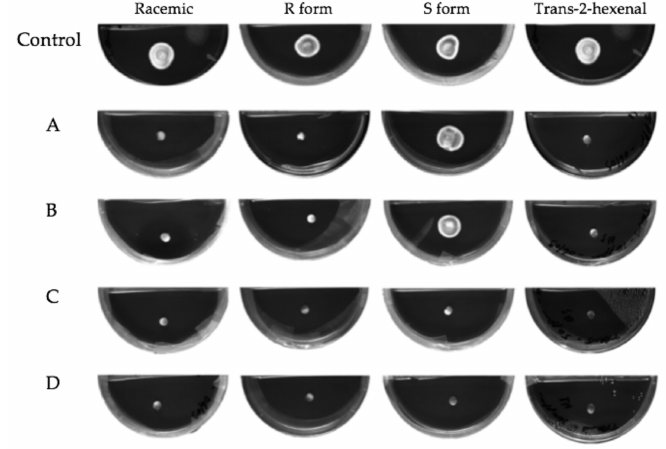
Figure 3. Mycelial plugs of Pseudogymnoascus destructans exposed to vapors of for 3 weeks at 15 ◦ C. VOC treatments as follows: ( A ) 0.04 µ mol of the three forms of 1-octen-3-ol or 0.05 µ mol of trans -2-hexenal; ( B ) 0.08 µ mol/mL of 1-octen-3-ol or 0.1 µ mol trans -2-hexenal; ( C ) 0.4 µ mol/mL 1-octen-3-ol or 0.5 µ mol/mL trans -2-hexenal; ( D ) 0.8 µ mol/mL 1-octen-3-ol or 1.0 µ mol/mL trans